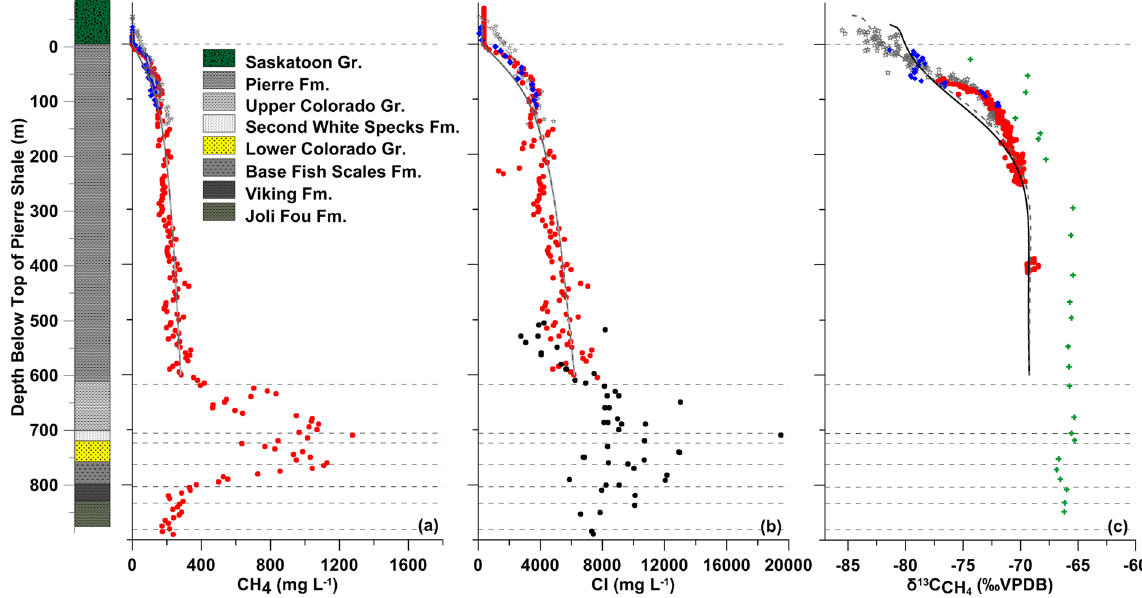
Figure 4. Geology and dissolved CH 4 concentrations ( a ), Cl − concentrations ( b ), and δ 13 C-CH 4 values ( c ) through the Quaternary deposits and Cretaceous shales at Sites 2, 5, 6, and 7. In ( a ) and ( b ), Isojar ® data from Sites 2 and 5 are shown as solid blue diamonds and grey stars, respectively, and calibrated mud gas data from Sites 2, 5, and 6 as dashed black line, solid black line, and solid red circles, respectively. Measured Cl − concentrations from the base of the Pierre Fm to the Joli Fou Fm from a drill site located 250 km SE of the study area 22 are presented as solid black squares in ( b ). In ( c ), IsoTube ® data from Sites 2 and 7 are presented as solid blue diamonds and green crosses, respectively, and mud gas data from Sites 5 and 6 as solid pink inverted triangles and solid red circles, respectively. The best-fit 1-D diffusive modeling results (1.6 Ma and 0.3 Ma for Sutherland and Saskatoon Group tills, respectively) are presented as solid lines (Sites 2 and 6) and dashed lines (Site 5) in ( a ), ( b ), and ( c